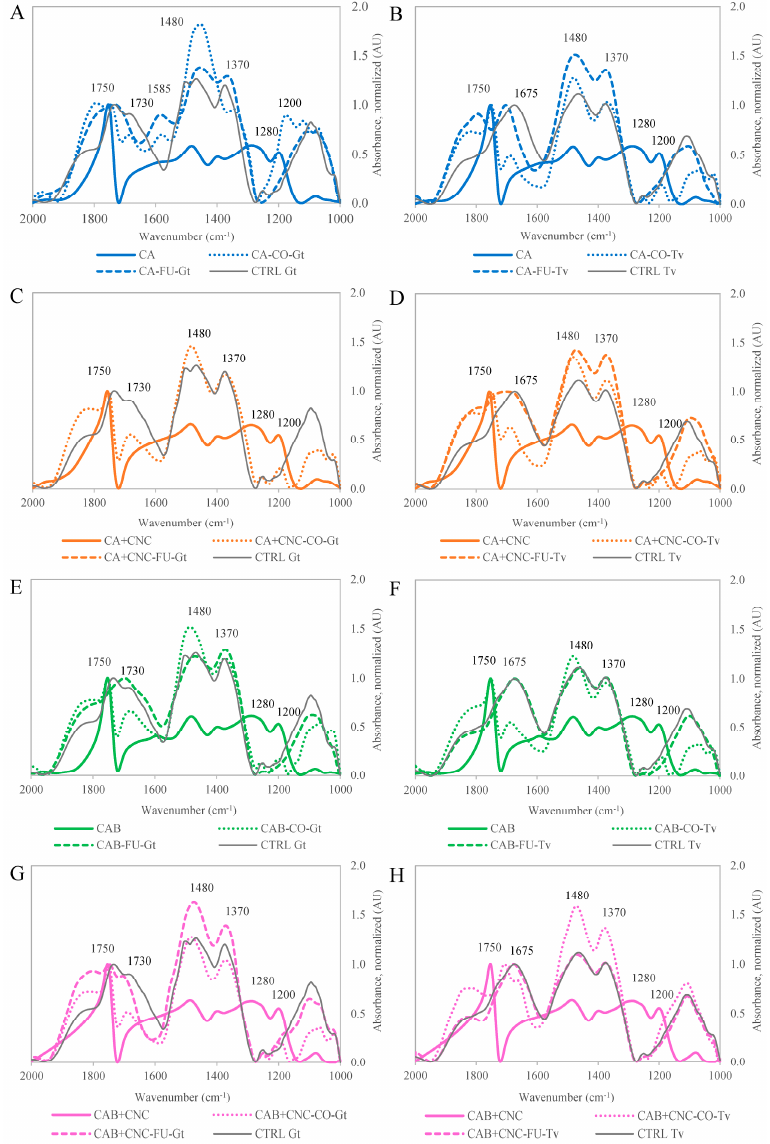
Figure 9. FTIR spectra of the coated wood samples. CTRL: Control samples exposed to wood rot. CA, CA+CNC, CAB, CAB+CNC: Coated wood samples not exposed to wood rot. CO: Spectra acquisition on coated wood samples exposed to wood rot, where the spot of measurement was mycelium